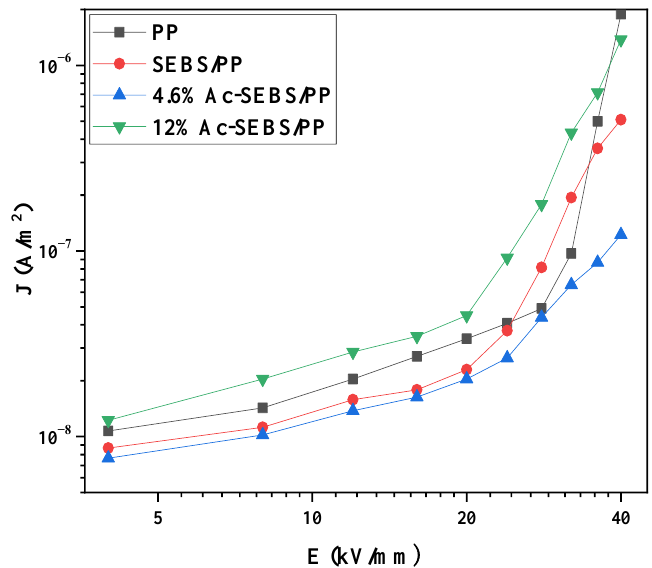
Figure 9. The conductive current of PP and its blends.